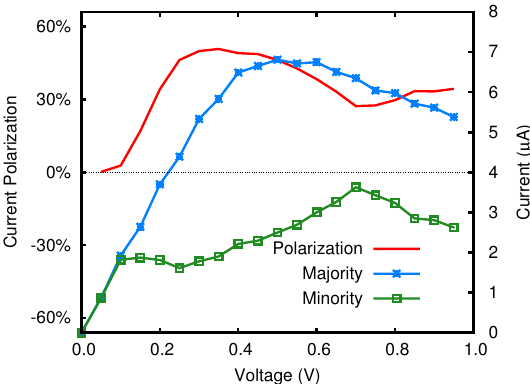
Figure 10. I ( V ) curve in the FeP nanojunction with B-doped electrodes.